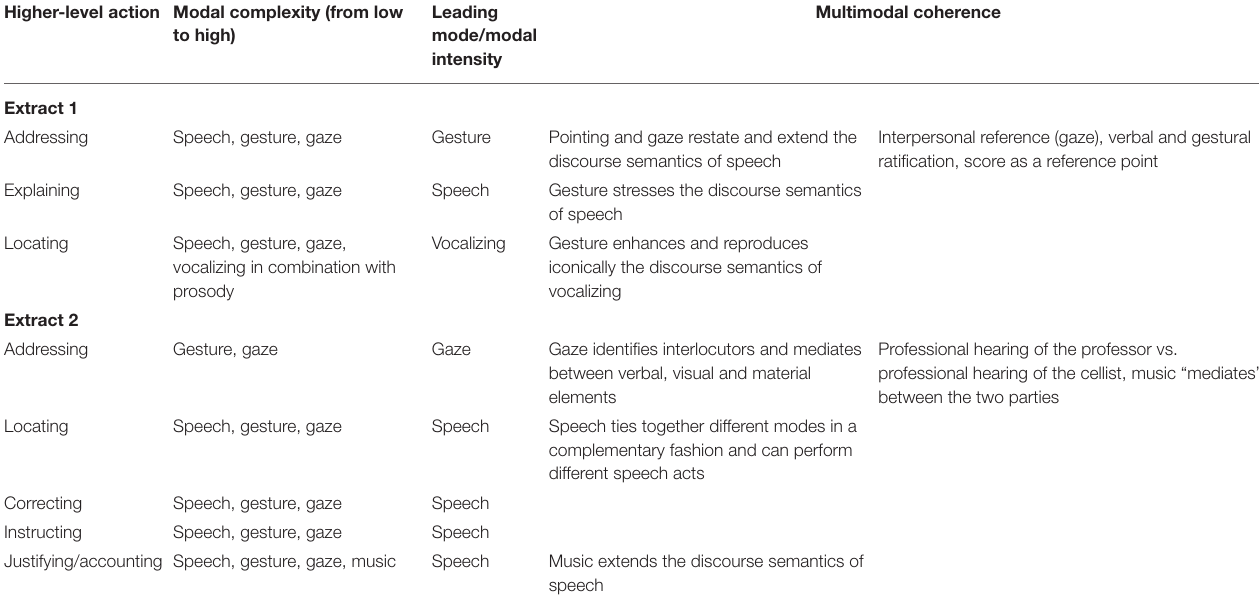
TABLE 1 | Complexity, intensity, and coherence of actions and modes. Higher-level action Modal complexity (from low to